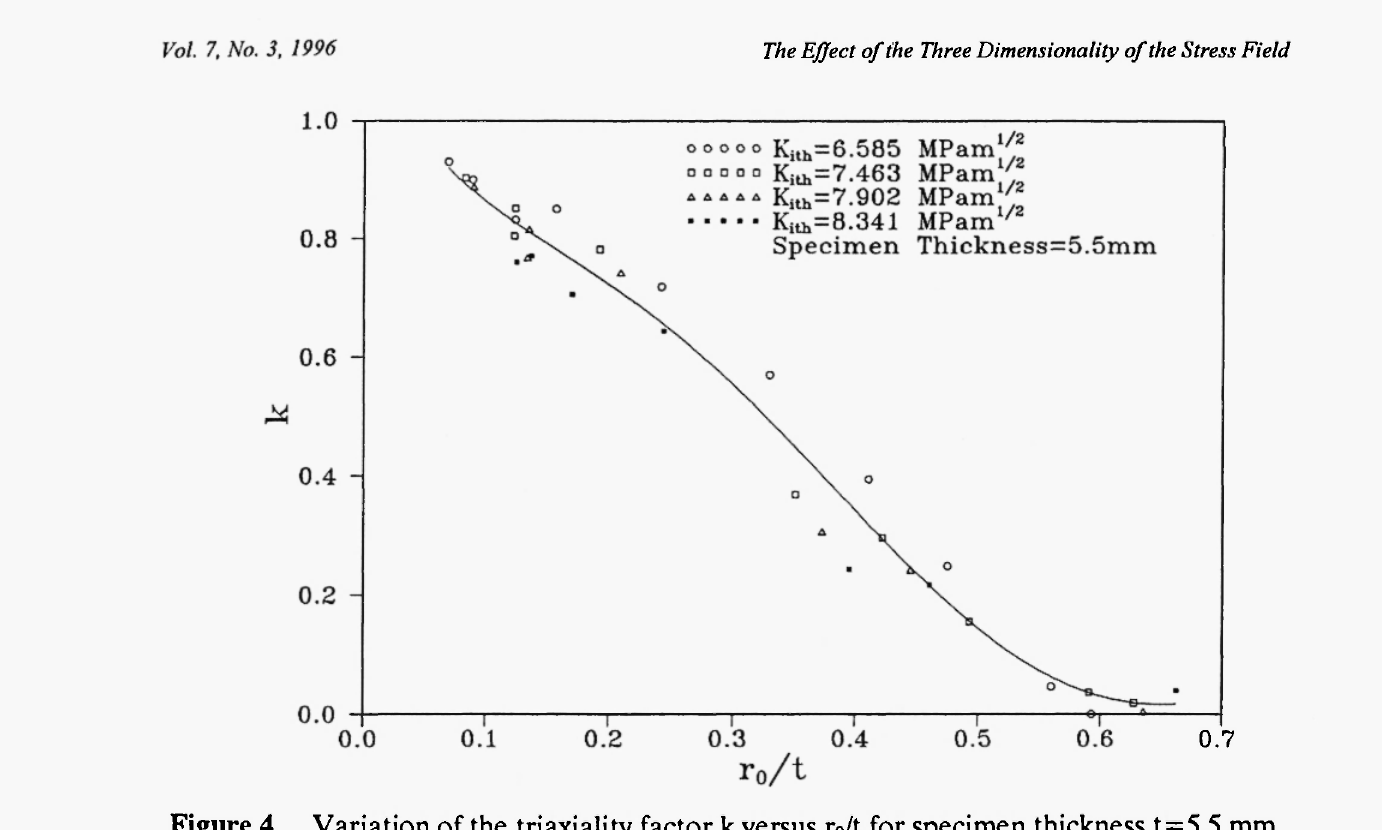
Figure 4 Variation of the triaxiality factor k versus ro/t for specimen thickness t=5.5 mm l.o